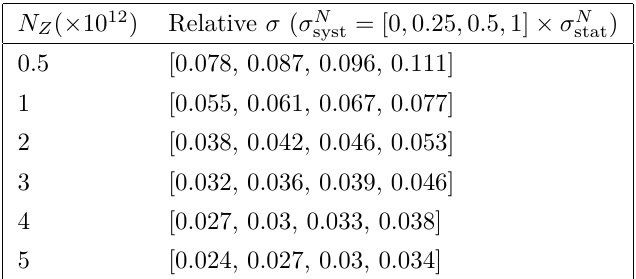
→ τ + ν τ ) as a function of N Z , where four different c